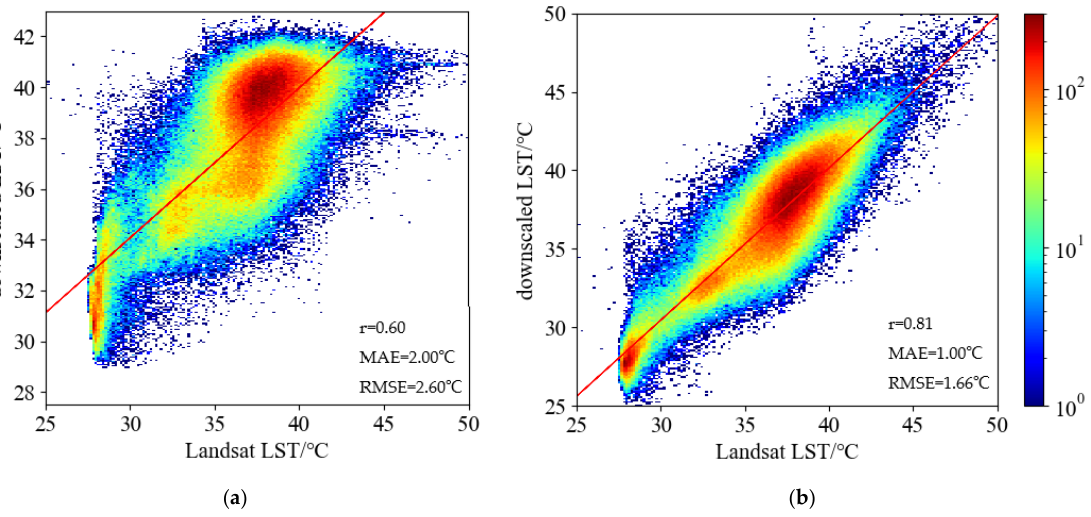
Figure 4. Scatterplots of the correlation analysis between downscaled LST and Landsat reference LST at a 30-m resolution. ( a ) Downscaled LST of Sentinel-3 from DRFD method. ( b ) Downscaled LST of Sentinel-3 from SSRFD method.